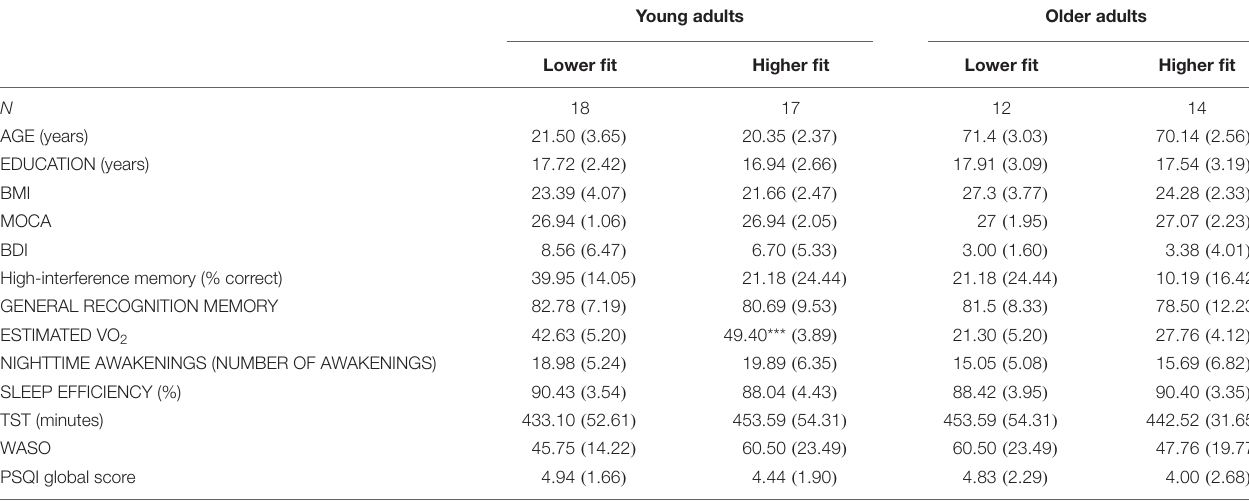
TABLE 1 | Descriptive characteristics of the present sample.